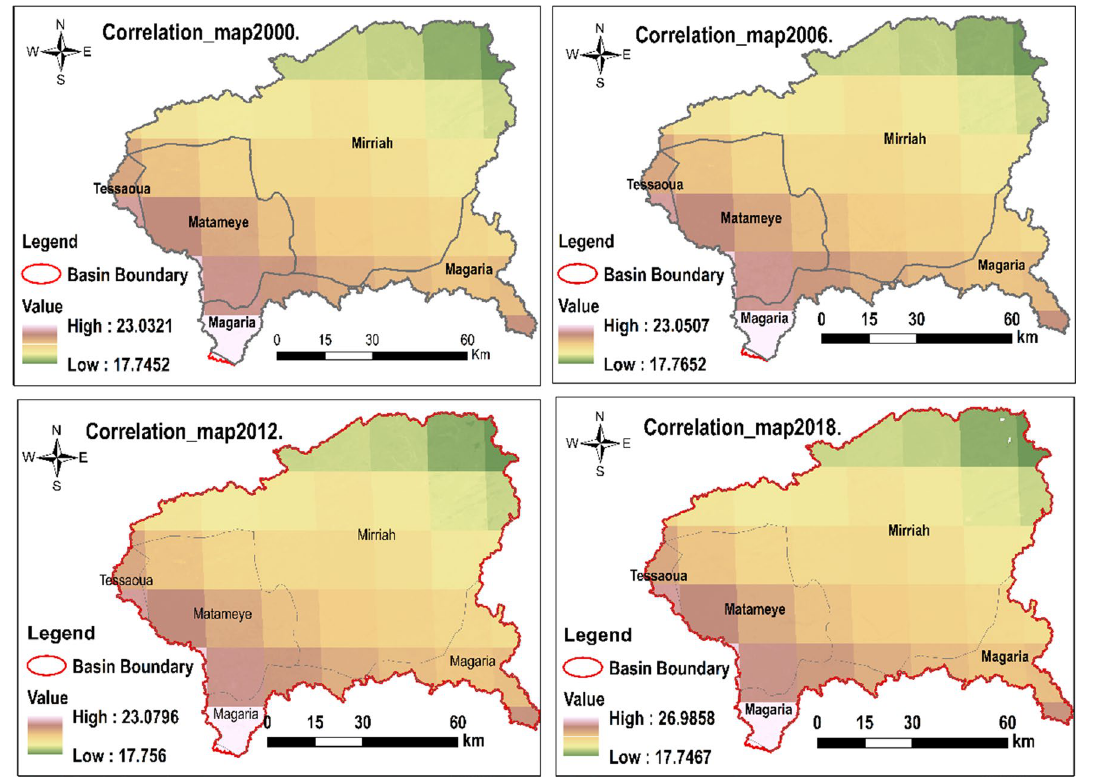
Fig. 4 Maps of the NDVI correlation coefficients per season and climatic